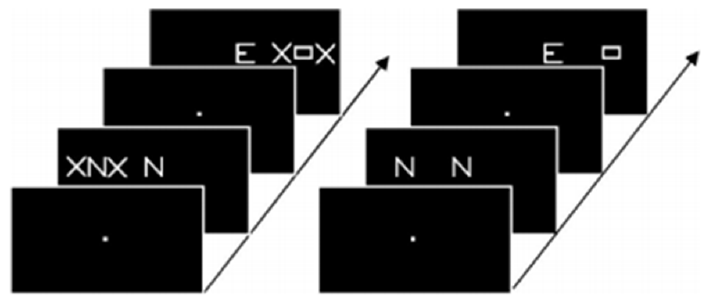
Figure 3. Example of stimuli used by Peyrin et al. [44] in their categorization task. Participants had to decide whether the stimuli of a pair were identical or not. Parafoveal stimuli were lateralized in either the right or left visual field, masked by two X in the flanked condition ( left side of the figure) and displayed alone in the isolated condition ( right side ).